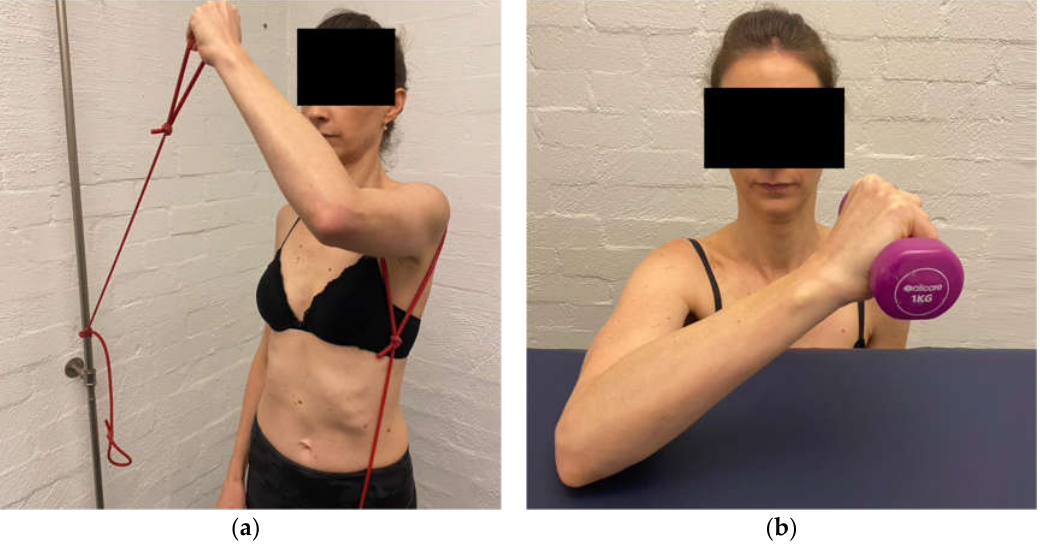
Figure 10. ( a ) External rotation in the sagittal plane with TheraBand TM . ( b ) External rotation in the sagittal plane with weight.